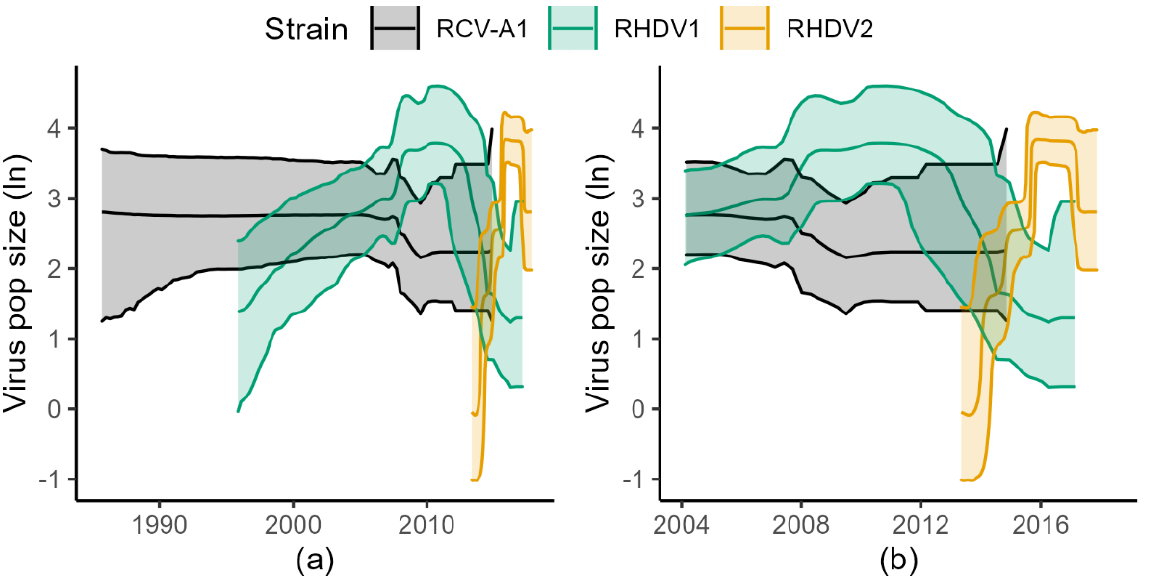
Figure 2. Bayesian Skyline Plots of the three lagoviruses. The left panel ( a ) shows the complete timeline (until the root of RCV-A1, in the early 1980s). In the right panel ( b ) the x -axis is limited to the time interval between 2004 and 2018 to facilitate comparison of the dynamics of the three viruses. Shaded areas are the 95% Highest Probability Density and solid lines are the posterior medians (in natural log).